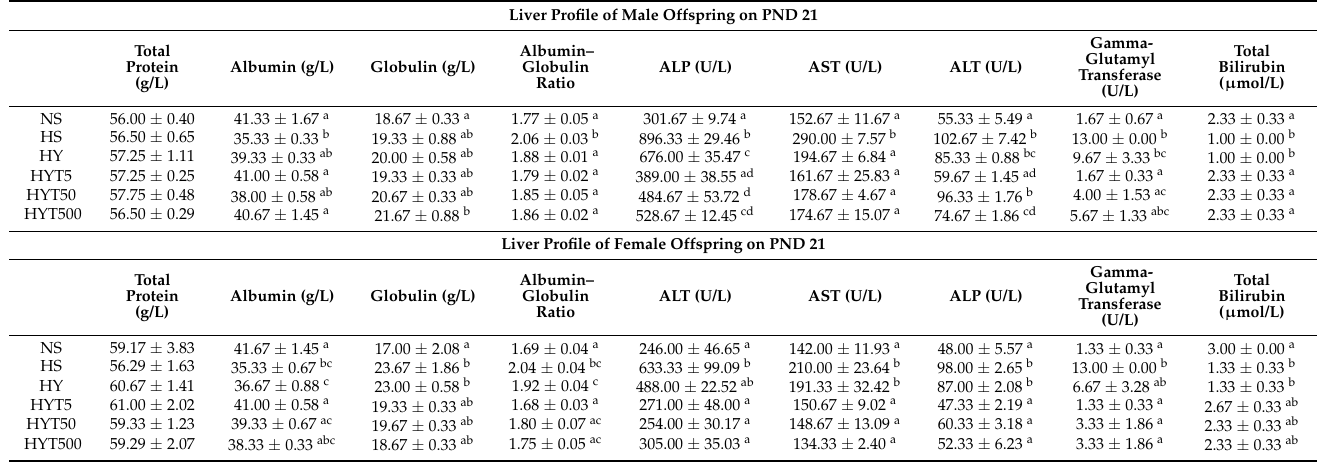
Table 2. Liver profile of male and female offspring on PND 21. Liver Profile of Male Offspring on PND